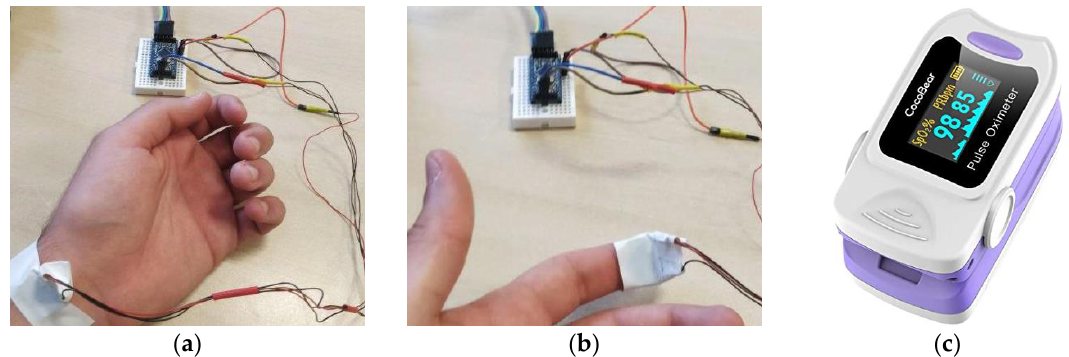
Figure 19. The positioning of the MAX30102 sensor on the wrist ( a ) and the fingertip for the correct detection of heart rate and blood oxygenation (SpO 2 ) ( b ); CocoBear pulse-oximeter used for the sensor characterization ( c ). Table 5. Detected heart rate (HR) and blood oxygenation (SpO 2 ) values using the CocoBear oximeter and the MAX30102 sensor; differences reported in the fifth and sixth column are between HR and SpO2 values supplied by CocoBear and MAX30102 devices; also the skin temperature acquired by the MAX20102 sensor is reported.